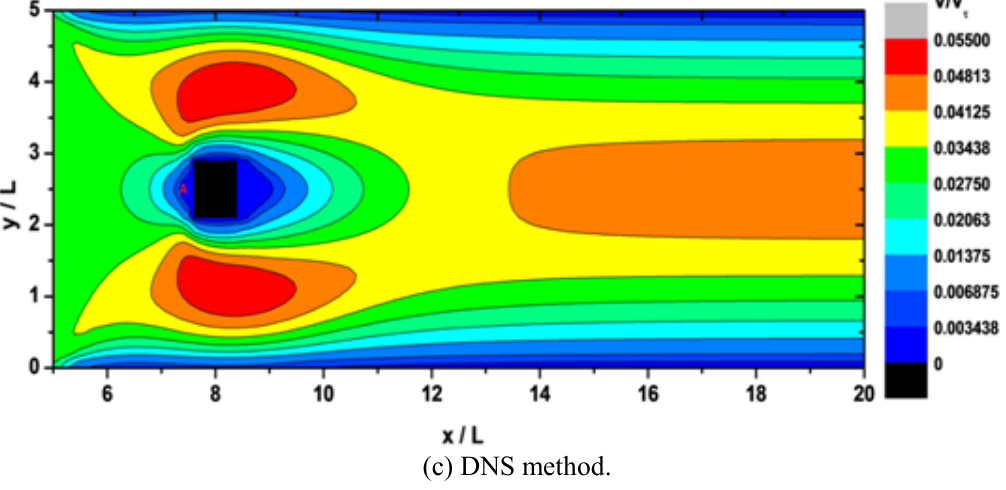
Fig. 11. comparison diagram of velocity contour at t=8s for the different